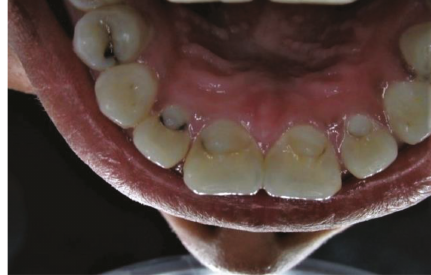
Figure 18: Case 4: talon cusps in all upper anterior teeth.